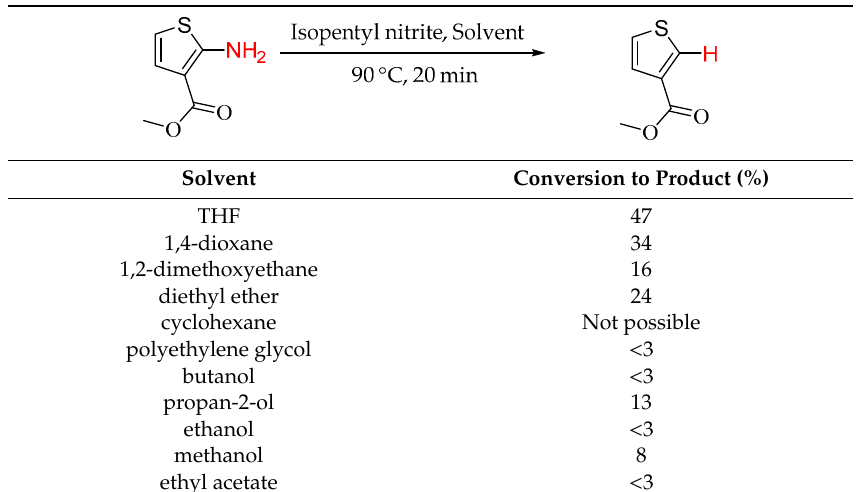
Table 1. Conversion of methyl 2-aminothiophene-3-carboxylate ( 1r ) to methyl thiophene-3-carboxylate ( 2r ) in a range of different solvents.